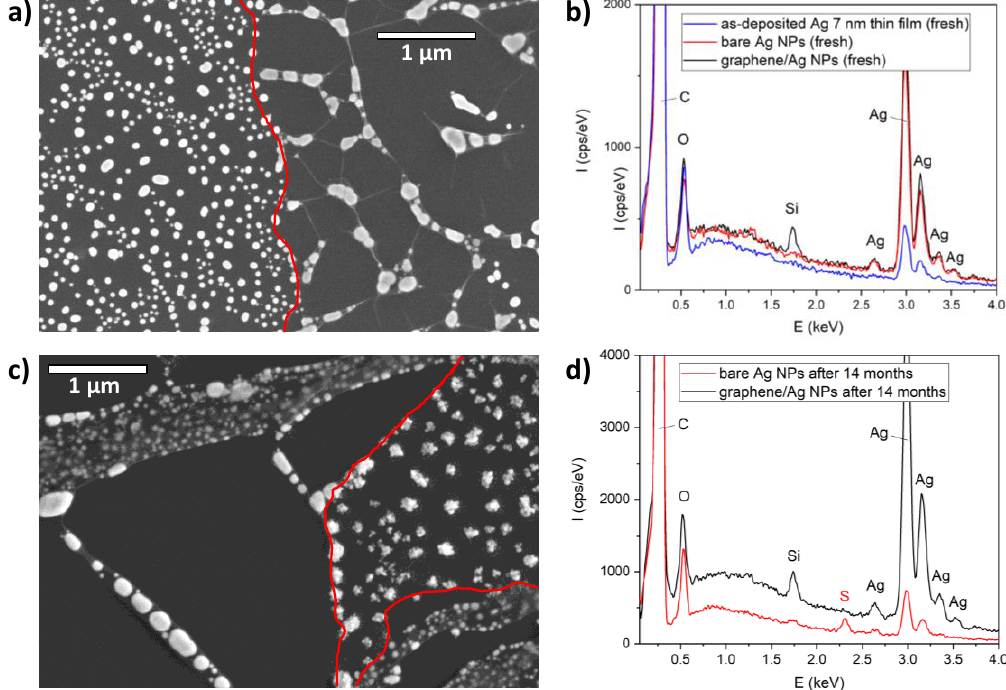
Figure 5. ( a ) SEM image of freshly prepared Ag NPs partially covered with graphene. The graphene edges are marked with red lines as guides for the eye. ( b ) EDX spectra measured on freshly prepared 7 nm Ag thin film (blue), bare Ag NPs (red), and graphene–Ag NPs (black). ( c ) SEM image of Ag NPs partially covered with graphene, 14 months after preparation. Graphene edges are marked with red lines as guides for the eye. ( d ) EDX spectra measured on bare Ag NPs (red) and graphene–Ag NPs (black), 14 months after preparation.